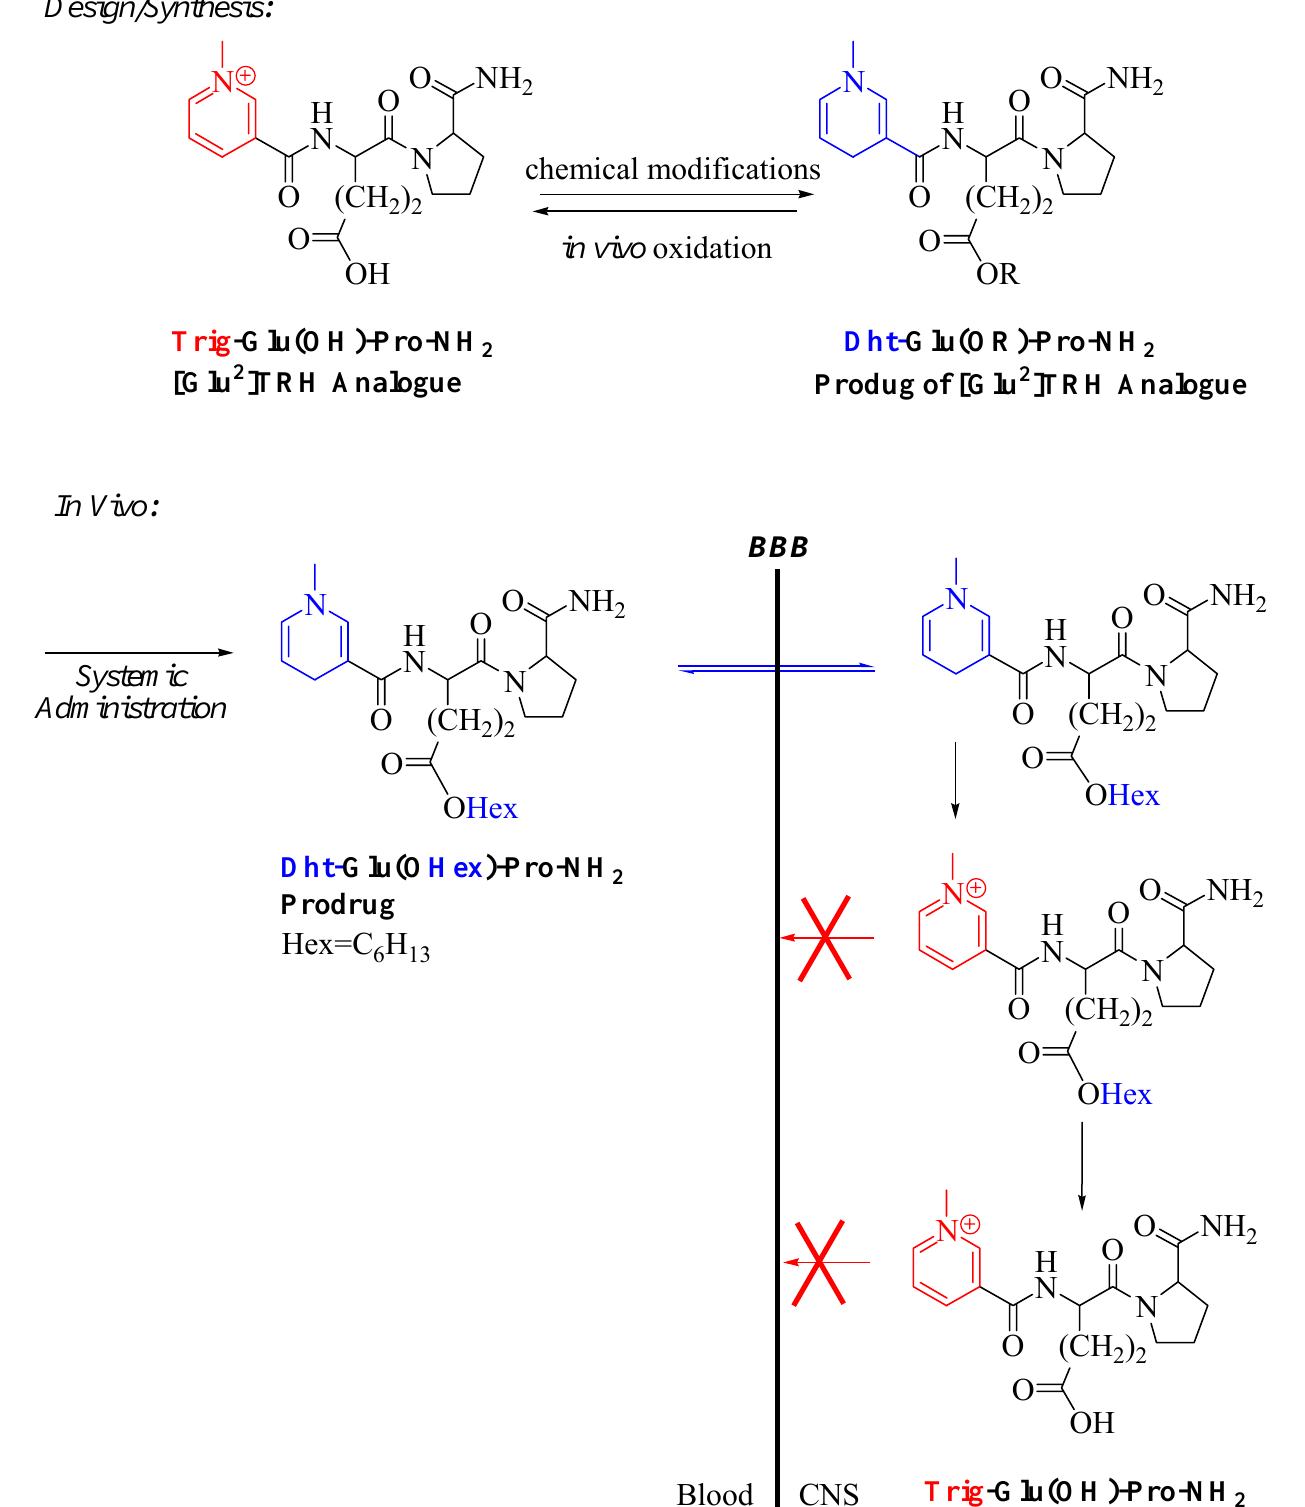
Figure 8 . Schematic illustration of the brain delivery concept for a [Glu 2 ]TRH analogue, Trig-Glu-Pro-NH , by prodrug 2